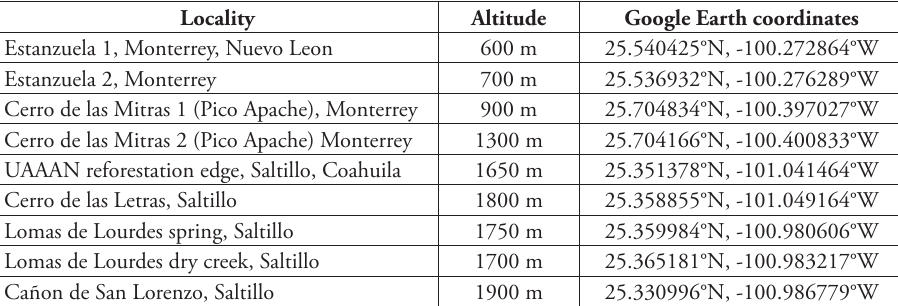
Table 5. Collection localities for Trachymyrmex